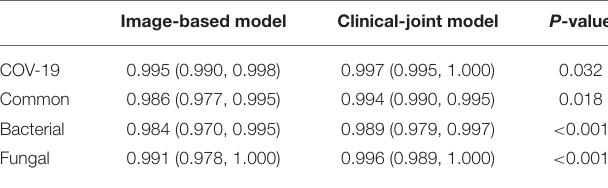
TABLE 4 | Receiver operating characteristic (ROC) of the Image-based model and Clinical-joint model.